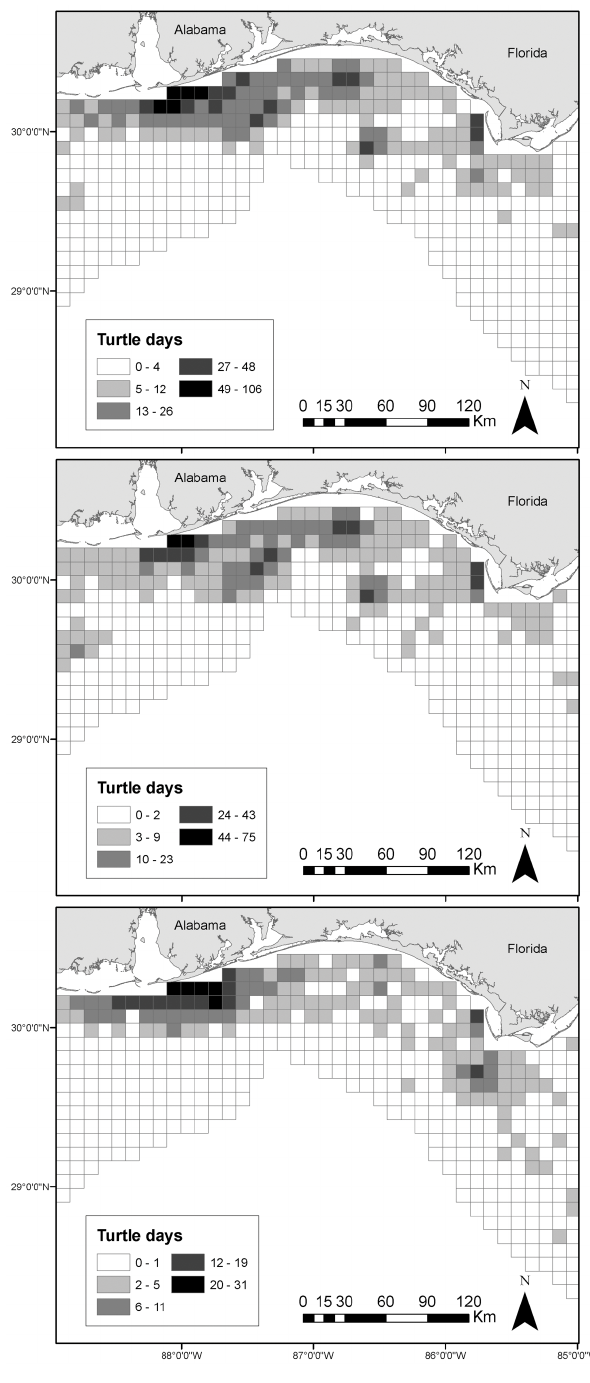
Figure 6. Number of loggerhead turtle ( Carettacaretta ) days spent for all (top), state-space modeled (SSM; middle) and non- SSM (bottom) turtles. Increasingly darker grid cells indicate a higher number of turtle-days per grid cell.